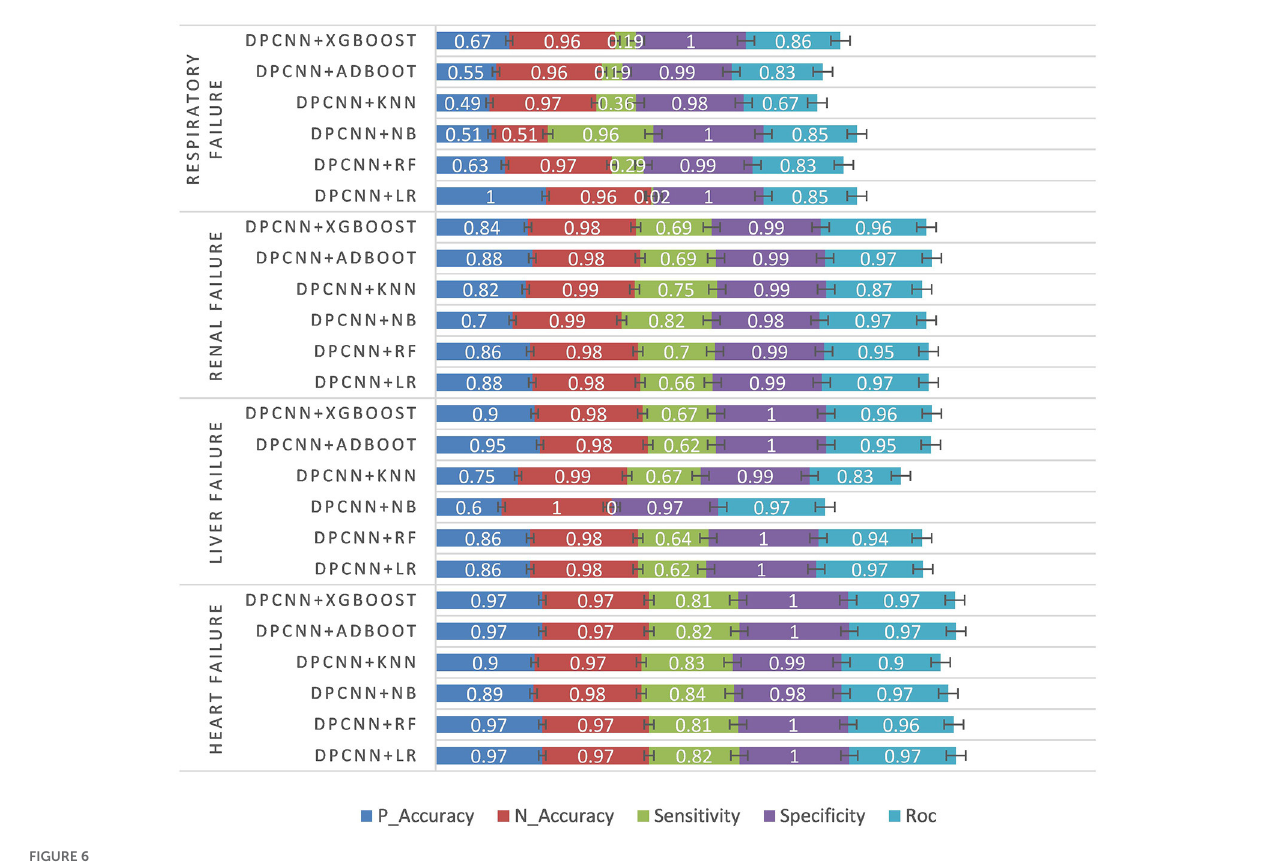
FIGURE6 Unstructured data experiment